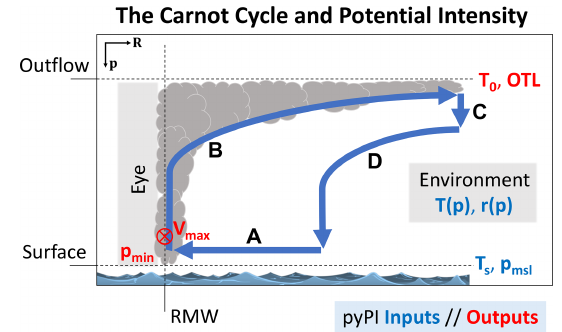
Figure 1. The cross section (along radius, R , and pressure, p ) of an idealized and mature tropical cyclone and its thermodynamic cycle. pyPI inputs and outputs are in blue and red text, respectively, and are defined in Table 1. Bold blue lines and black letters indicate the four branches of the Carnot cycle, A through D (see text). The tropical cyclone maximum potential intensity ( V max ) is found at the radius of maximum winds (RMW) and is directed into the page in the Northern Hemisphere. The minimum central pressure ( p min ) is found in the storm’s eye. Based on Carnot cycle illustrations in Emanuel (1987,